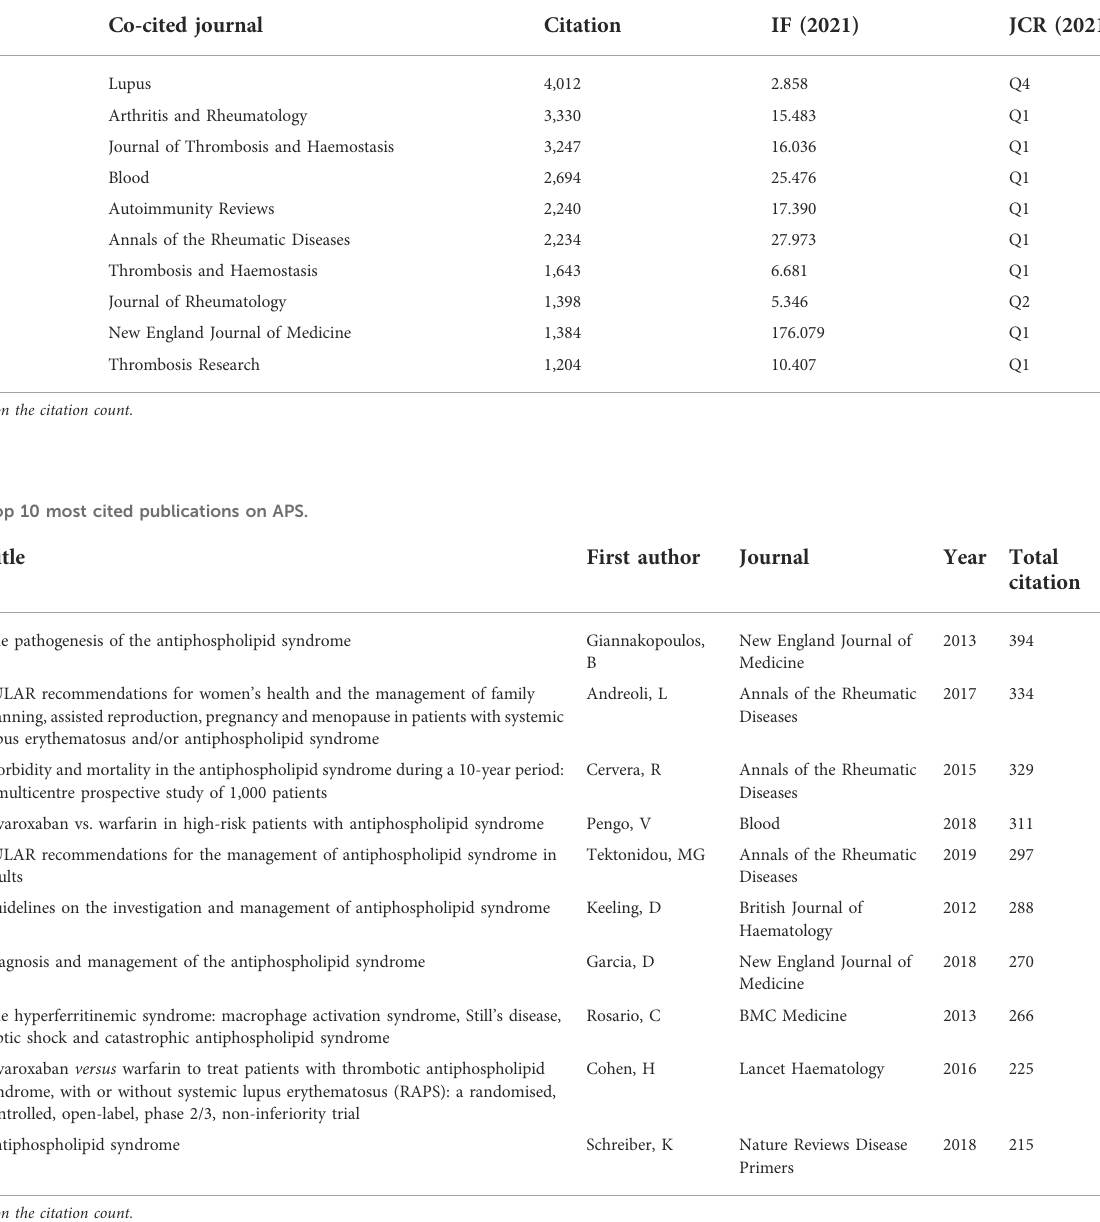
TABLE 6 Top 10 co-cited journals with the most citations related to